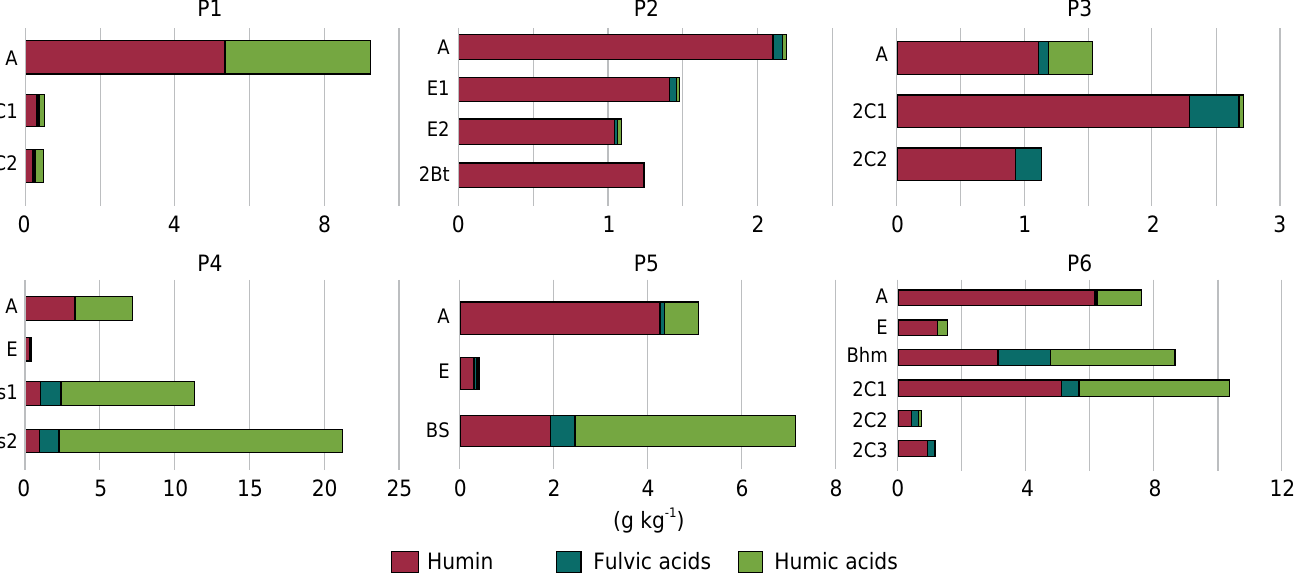
Figure 6. Fractionation of organic matter from the horizons of the collected